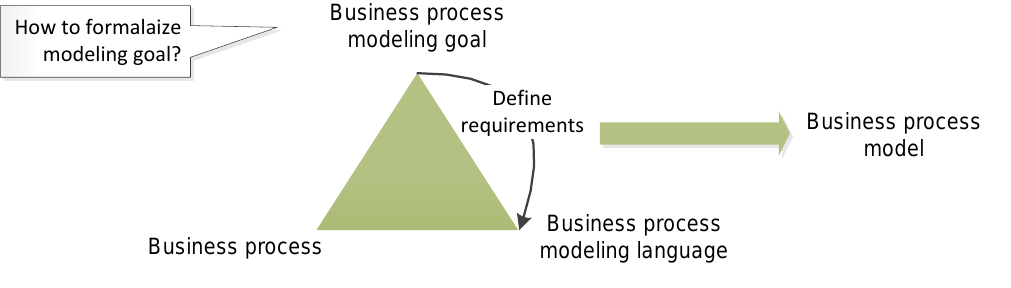
Figure 1. Interdependencies between a business process, modeling language, and modeling